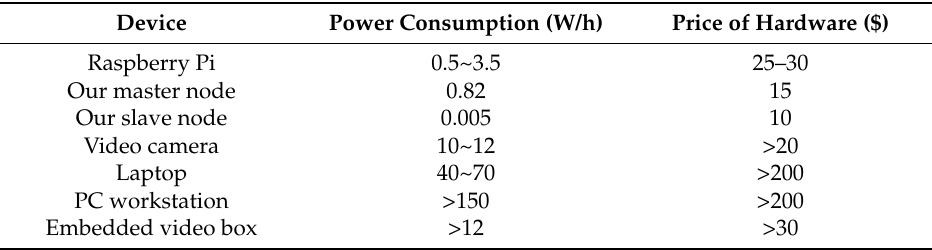
Table 7. Total Own Cost